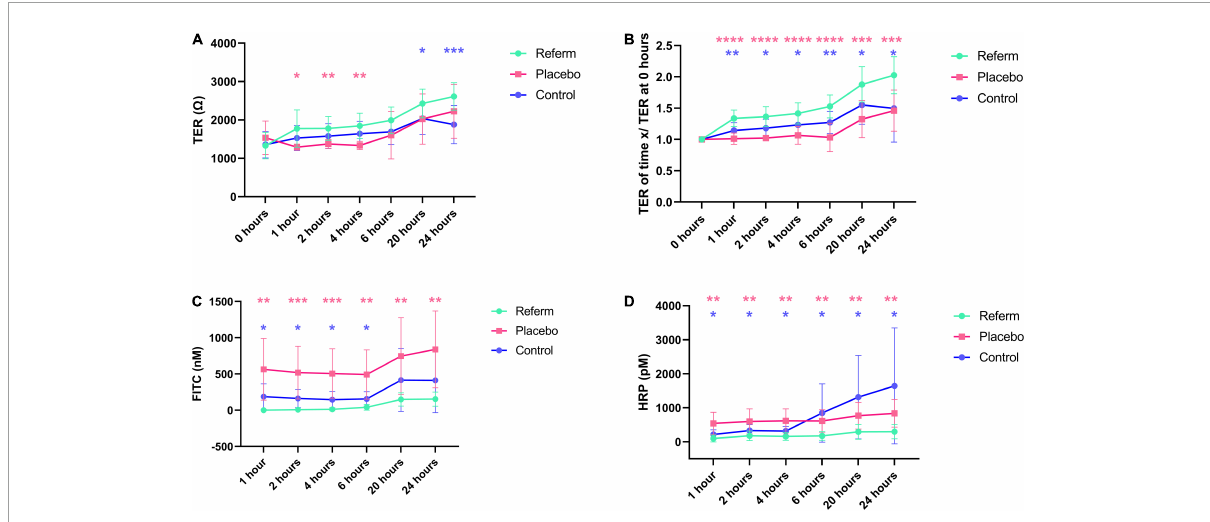
FIGURE4 Effects of the fermented oat gruel, ReFerm R (cid:13) , on the barrier function over time in vitro . (A) Transepithelial resistance (TER) in Caco-2 cells treated with ReFerm R (cid:13) , placebo, or untreated control. (B) TER normalised against the baseline measurements (0 h). (C) The paracellular permeability is decreased in ReFerm R (cid:13) -treated cells compared to untreated or placebo-treated cells. (D) The transcellular permeability is significantly decreased in ReFerm R (cid:13) -treated cells compared to untreated controls. Data are presented as mean ± standard deviation (SD) ( n = 12 wells per condition per time point) * p < 0.05, ** p < 0.01, *** p < 0.001, **** p < 0.0001. Pink stars represent the comparison between ReFerm R (cid:13) and placebo, while the blue stars represent the comparisons between in ReFerm R (cid:13) - and